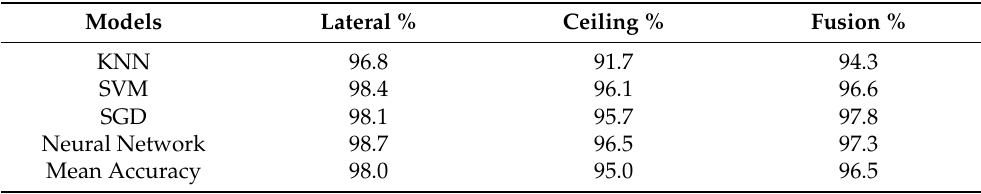
Table 5. Evaluation results for Lateral (T1), Ceiling (T2) and fused (F1) datasets using K-Means Clustering Method